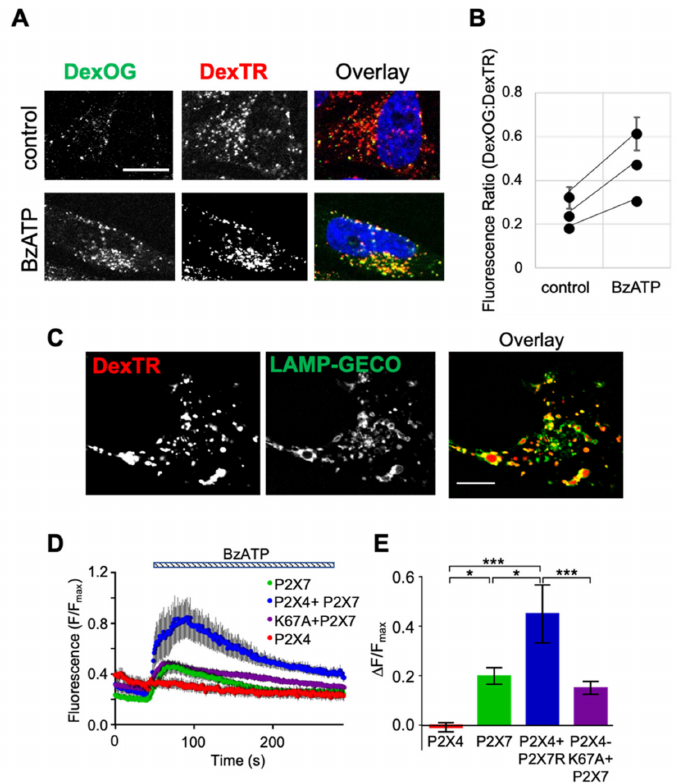
Figure 3. Stimulation of P2X7 receptors promotes endolysosome alkalinization and an enhanced P2X4 receptor-dependent Ca 2+ signal. ( A ) Representative images of cells co-expressing rP2X4 and rP2X7 with endolysosomes labeled with the pH-sensitive Oregon Green 488 10 kD Dextran (DexOG) and pH-insensitive DexTR either with or without treatment with 30 µ M BzATP for 0.5 h. ( B ) The fluorescence ratio of DexOG to DexTR per lysosome was increased in response to BzATP addition. The mean and SEM of this ratio for control and BzATP treated cells is shown for three independent experiments (557–2050 lysosomes per experiment). ( C ) Colocalization between LAMP1-GECO- and DexTR-positive compartments. ( D ) Changes in mean cellular LAMP1-GECO fluorescence during application of 30 µ M BzATP in HBS is shown for cells expressing rP2X4 and rP2X7 receptors individually or together, or rP2X7 with the rP2X4K6A mutant, as indicated. The mean cellular fluorescence ± SEM was obtained from 50 cells per condition from a single experiment, and, for each cell, the response was normalized to the maximal response (F max ) obtained by a final addition of ionomycin plus 5 mM Ca 2+ . ( E ) The mean peak amplitudes of the BzATP-evoked responses normalized to F max , from three separate experiments, are plotted for all of the receptor combinations. Results are the mean ± SEM. * p < 0.05, and *** p < 0.001; one-way ANOVA followed by